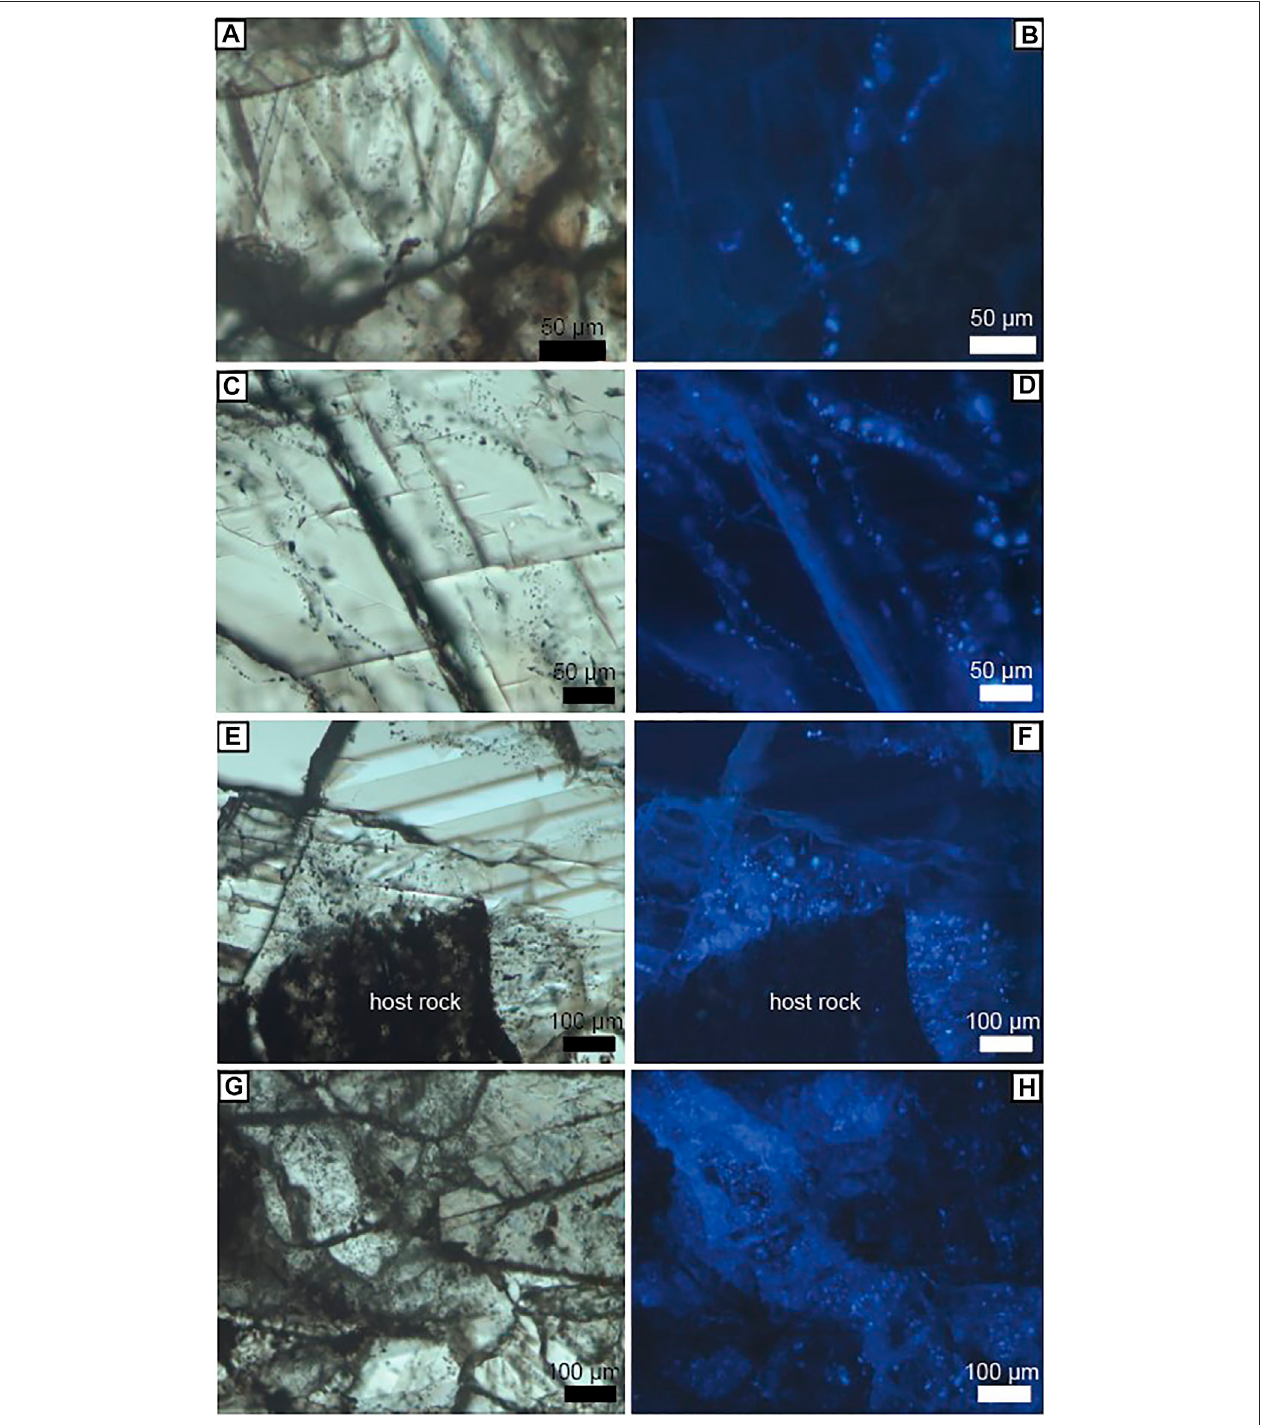
FIGURE 5 | Petroleum fl uid inclusion photomicrographs. (A) Secondary bi-phase petroleum inclusions forming along cleavage planes. (B) Same as fi eld of view (FOV)aspreviousunderUVilluminationshowing fl uorescingpetroleuminclusions. (C) Healedfracturesincalciteveinwithsinouspathsofsecondarybi-phasepetroleum inclusions(2055m). (D) Same FOVaspreviousunderUVillumination. (E) Primarybi-phasepetroleum inclusionsfrom brecciated zone(2055m) displaying maturationof organic matter from host rock and exsolving petroleum fl uids. (F) Same FOV as previous under UV illumination. (G) Blocky calcite from brecciated zone (2055 m) with clouds of primary bi-phase petroleum inclusions within the cores of vein calcite crystals. (H) Same FOV as previous under UV illumination.